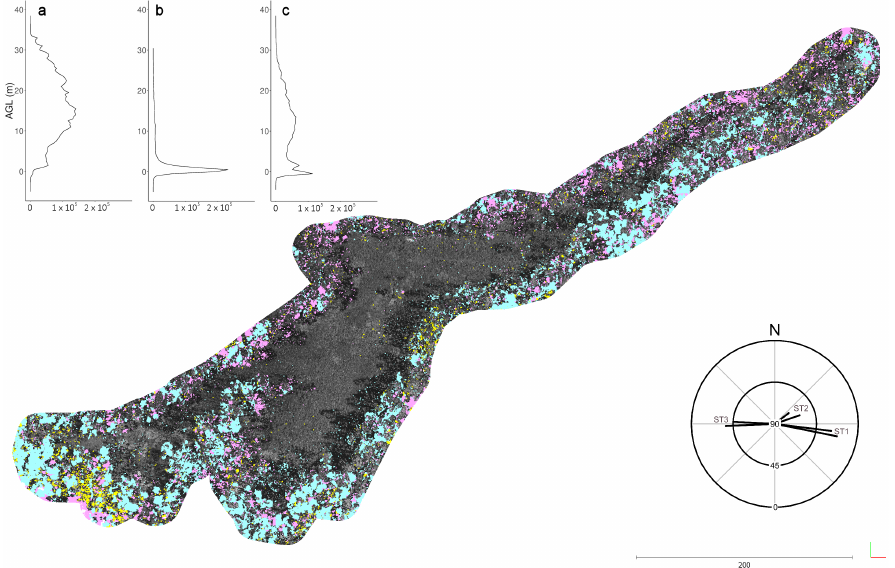
Figure 11. (main) Dense points identified in the morning, at midday, and in the afternoon that are more than 0.5 m from the nearest point registered in both other products from imagery sets processed using the green camera as master. Elevation profile (1 m bins) of unique point features for ( a ) morning (T1), ( b ) midday (T2), and ( c ) afternoon (T3). The radial plot shows the start and end solar azimuth and the elevation for the three imagery